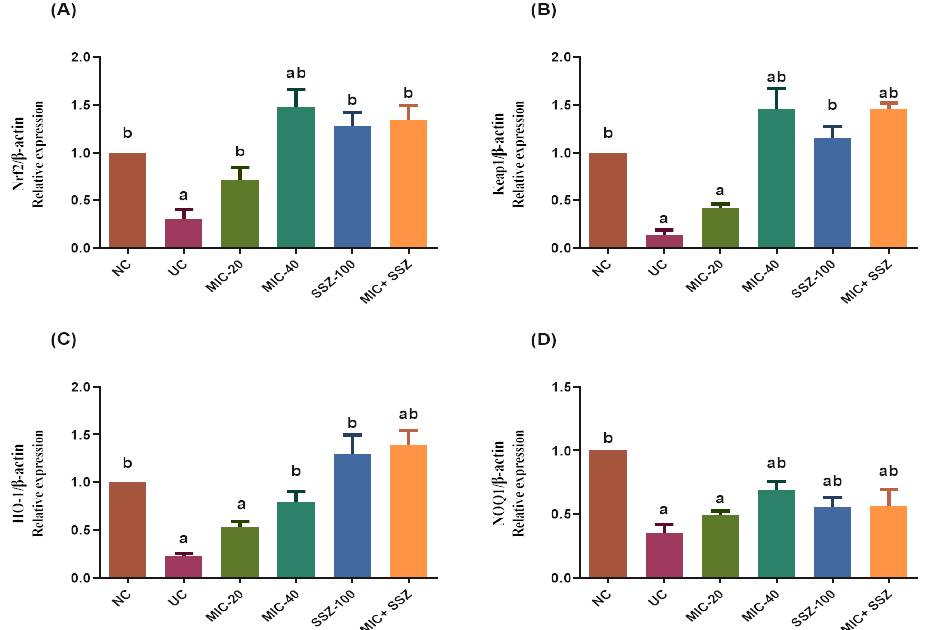
Figure 9. Effect of miconazole, sulfasalazine and their combination on mRNA expression of Nrf2 ( A ), Keap-1 ( B ), HO-1 ( C ) and NOQ1 ( D ) in AA-induced UC. Data are expressed as fold changes of negative control value ± SEM ( n = 5) after normalization by β -actin. a Significantly different at p ≤ 0.05 from the negative control (NC) values. b Significantly different at p ≤ 0.05 from the ulcerative colitis control (UC) values.